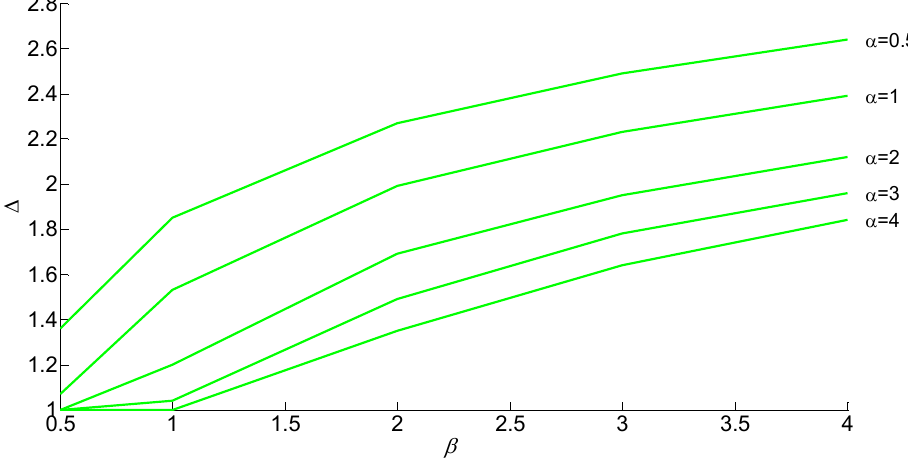
Figure 4. Trend of the “critical time interval”, Δ , which maximizes the water level, as a function of the spillway DC α and the SC β .